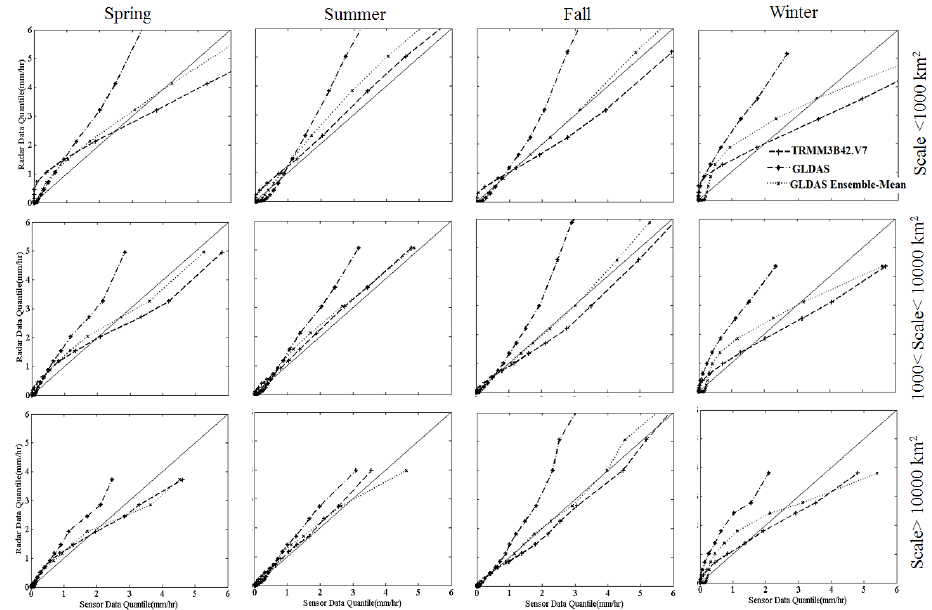
Figure 7. Quantile–quantile plots between sensor (TRMM3B42V7, GLDAS, and downscaled GLDAS) and radar precipitation values. Rows indicate different basin-scale categories. Columns represent the different seasons.